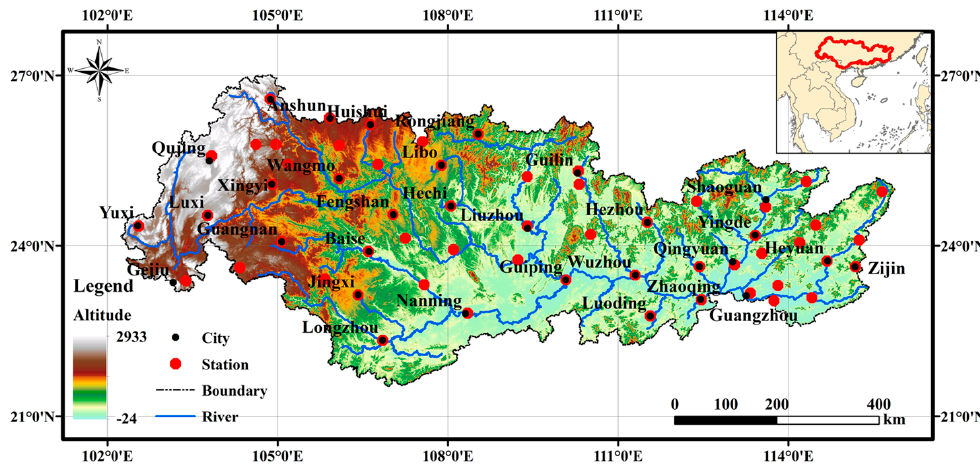
Figure 1. Location of the study area.